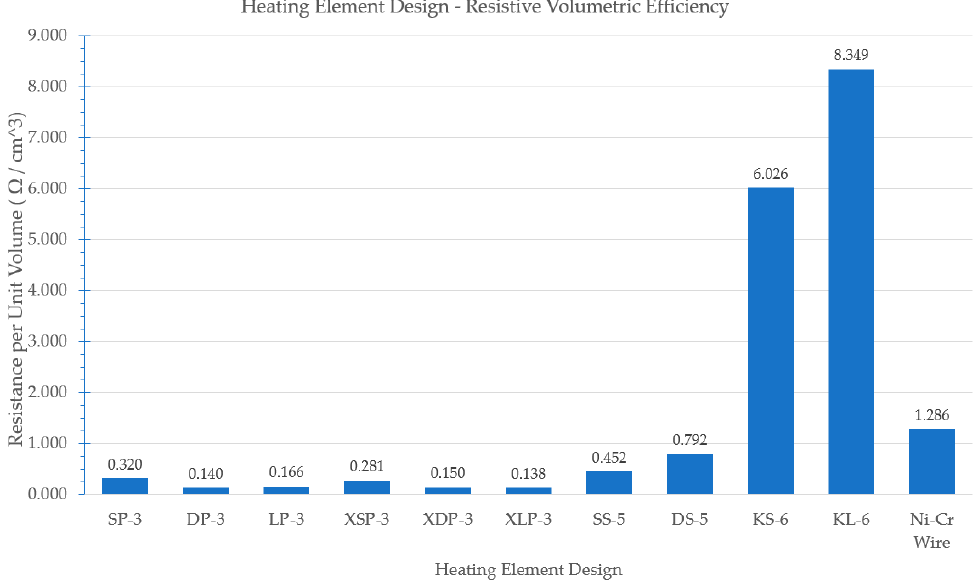
Figure A4. Resistance volumetric efficiency. Resistance per unit volume of actuator material of heating element designs. The Ni-Cr wire heater was also included in a 50 mm × 20 mm × 20 mm cylindrical actuator to provide a baseline against which to compare.